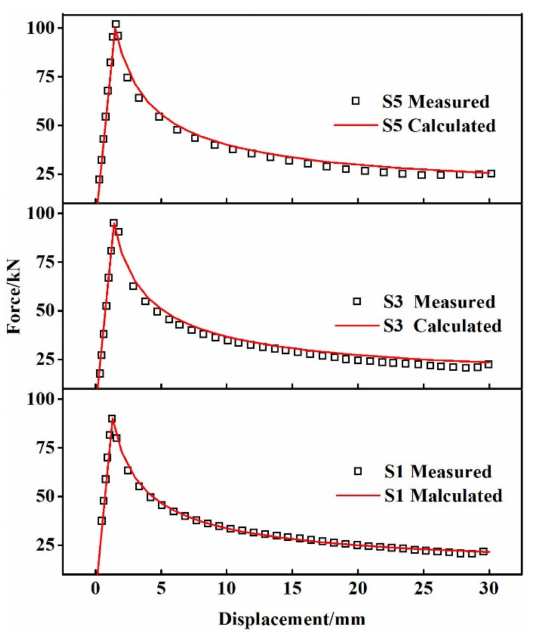
Figure 12. Comparison of calculated and measured results of the first two